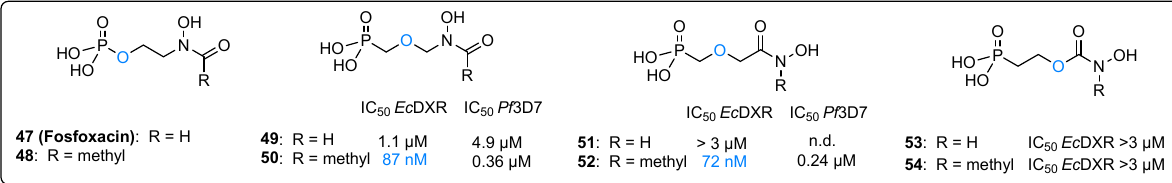
Figure 15. Structure and biological activity of the oxa analogs 47 – 54 .